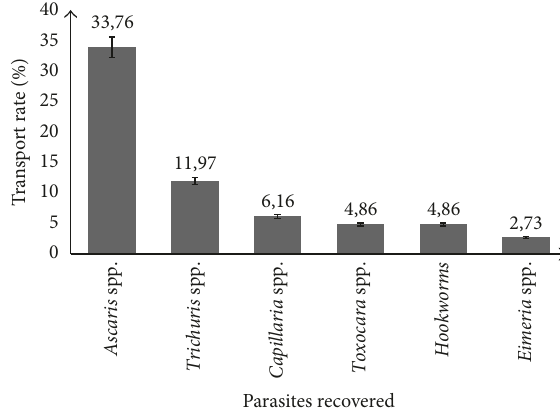
Figure 1: Transport rate of various parasites isolated from the cockroaches. Error bars = 95%